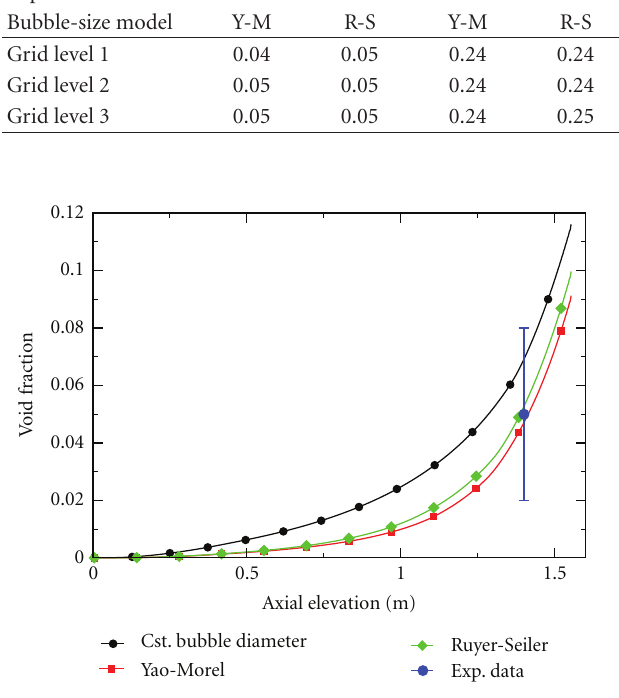
Figure 13: Comparison of calculated axial distribution of the mean void fraction for the bubble-size models. Table 8: Run 1.2211. Characteristics of the bubble-diameter at the measuring section with di ff erent modeling choices.